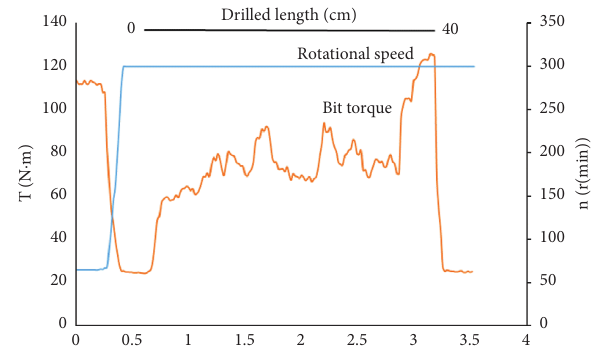
Figure 10: Drilling parameters of